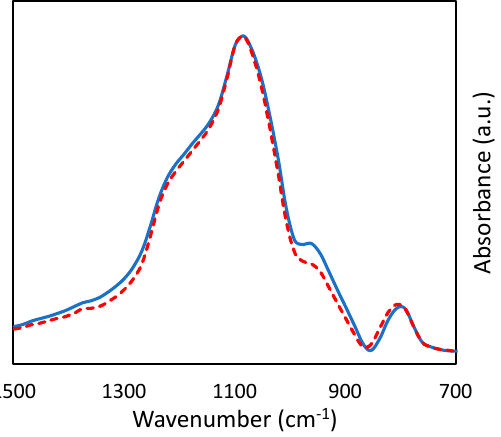
Figure 3. FTIR spectra obtained on 4TaSi NHSG -2Ag (solid blue line), 4Ta IMP Si-2Ag (dotted red line).